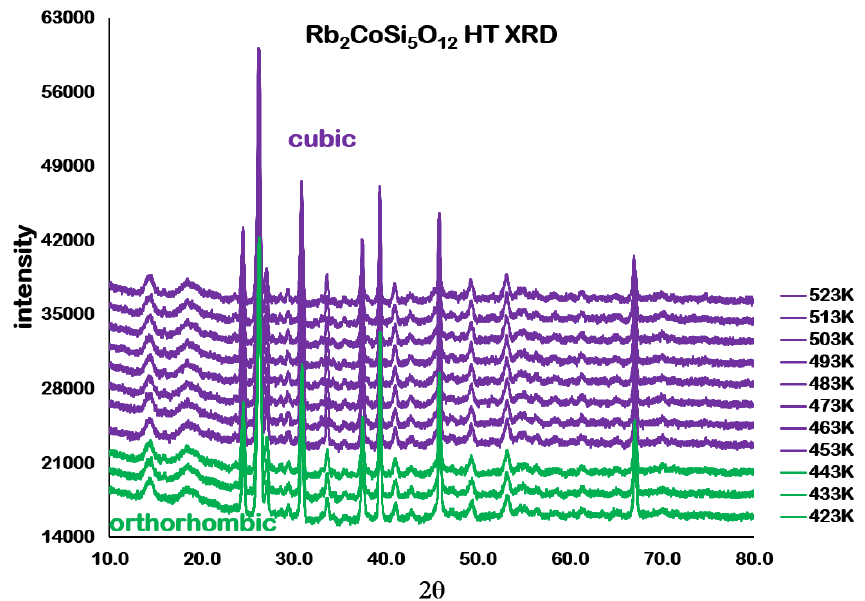
Figure 5. Plot showing XRD data for Rb 2 CoSi 5 O l2 25–27 °2 θ over the temperature range 423–523 K. Pbca orthorhombic data are shown in green and 𝑃𝑎 3 cubic are shown in purple. Broad peaks at approximately 14 and 18 °2 θ are due to the window material of the HTK1200N high temperature stage. Sharp peaks at approximately 39, 46 and 69 °2 θ are due to the platinum sample holder.